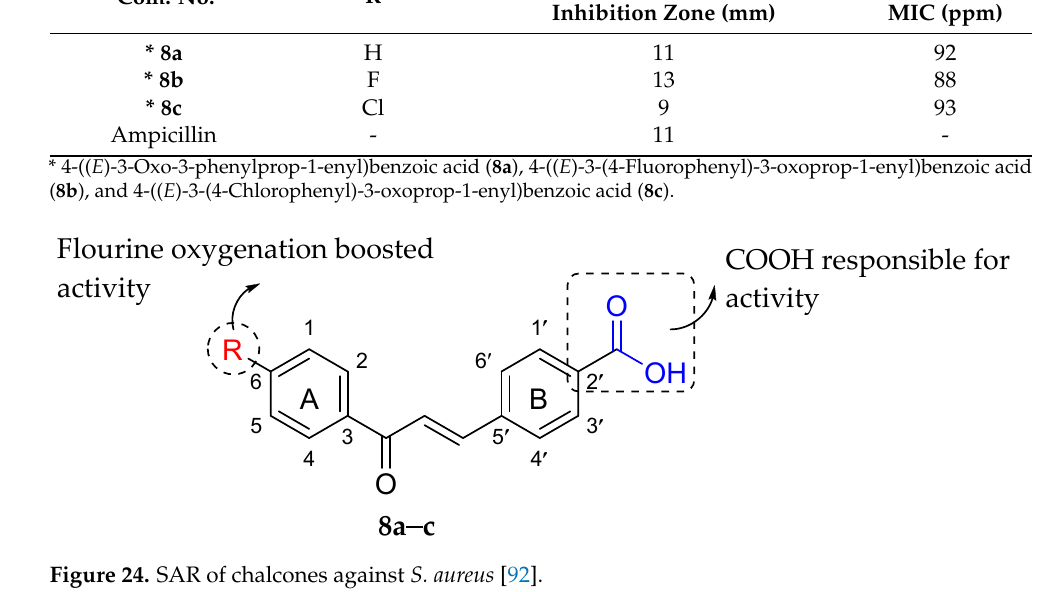
Table 14. Antibacterial activity of chalcones ( 8a – c ) against S. aureus . Com. No.